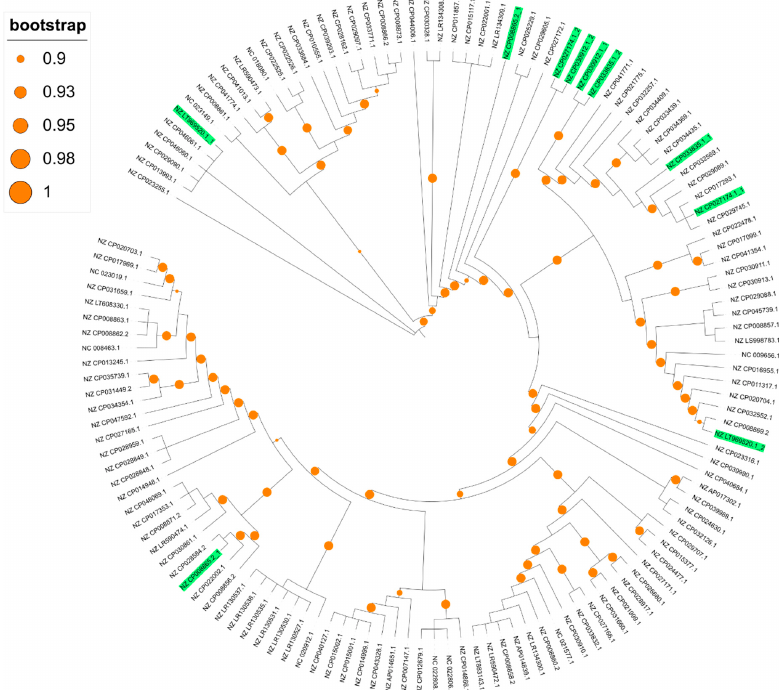
Figure 4. Approximately-maximum-likelihood phylogenetic tree base on the alignment of the 26 core genes identified in the crpP -harboring ICEs. Genome accession numbers containing more than one crpP -harboring ICE are highlighted in green. Branch lengths are ignored. Bootstrap values between 0.9 and 1 are represented by orange circles.